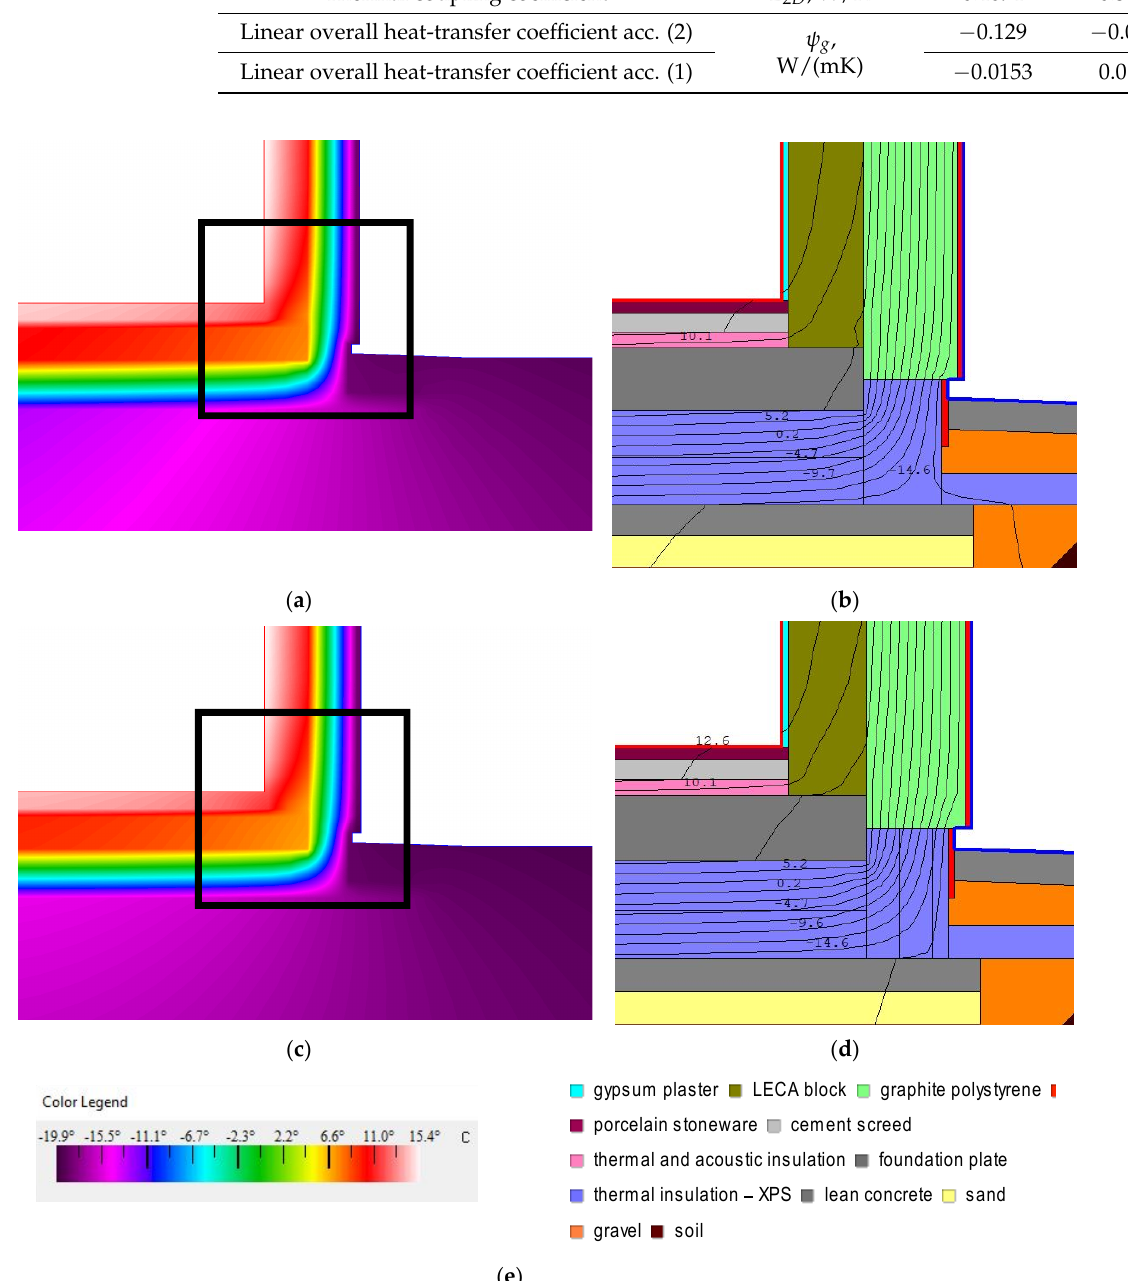
Figure 14. ( a ) Temperature field distribution in the cross-section of the detail wall–slab-on-ground for the case where B = 8 m, ( b ) Isotherms in the fragment marked with a square in figure ( a ), ( c ) Temperature field distribution in the cross-section of the detail wall–slab-on-ground for the case where B = 4 m, ( d ) Isotherms in the fragment marked with a square in figure ( c ), ( e ) Legends.